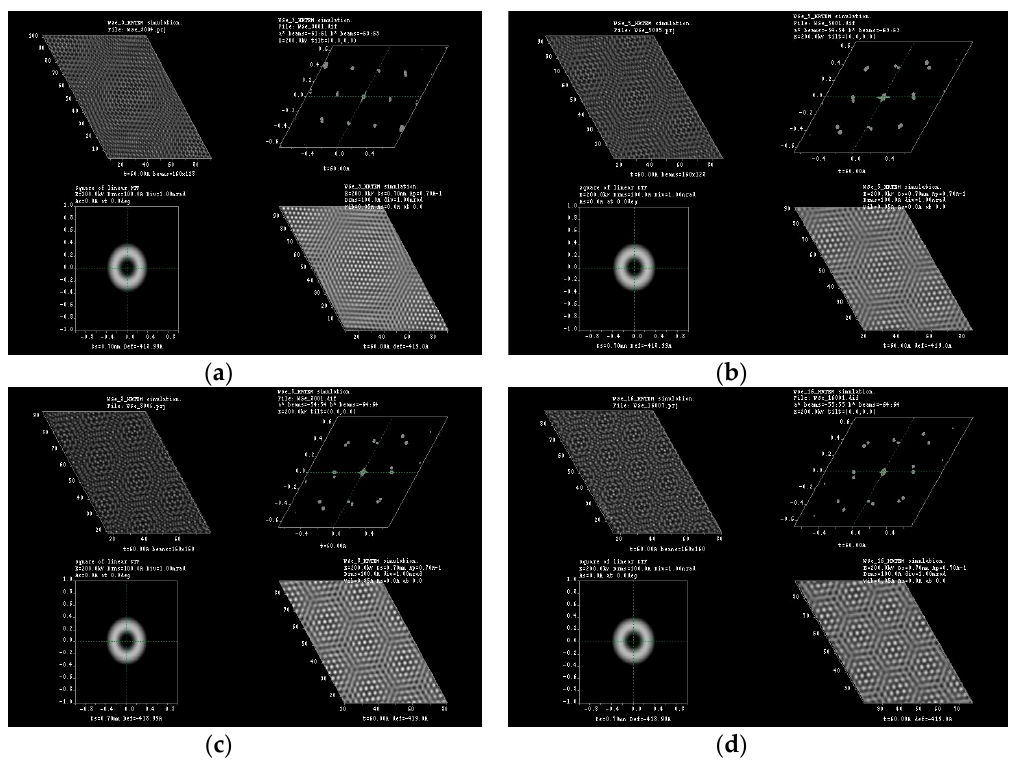
Figure 4. HRTEM simulation for ( a ) 3°; ( b ) 5°; ( c ) 8° and ( d ) 16° of rotation in tungsten disulfide molecular structure.